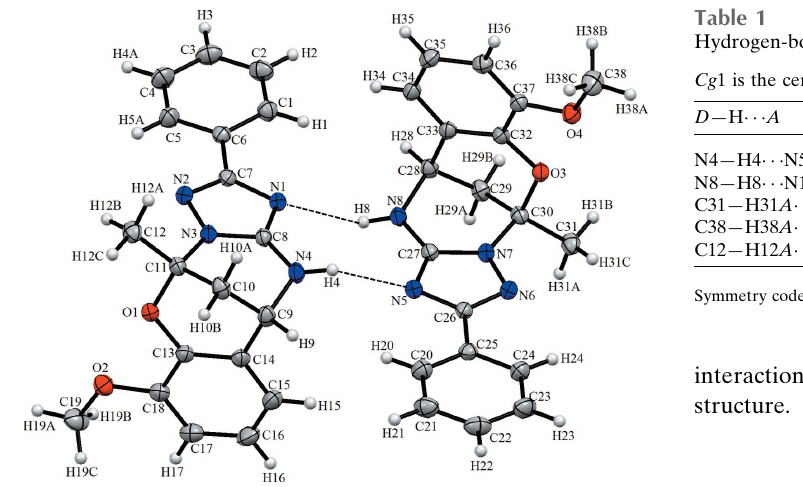
Figure 1 The molecular structure of the title compound, showing the atom labelling. Displacement ellipsoids are drawn at the 20% probability level.